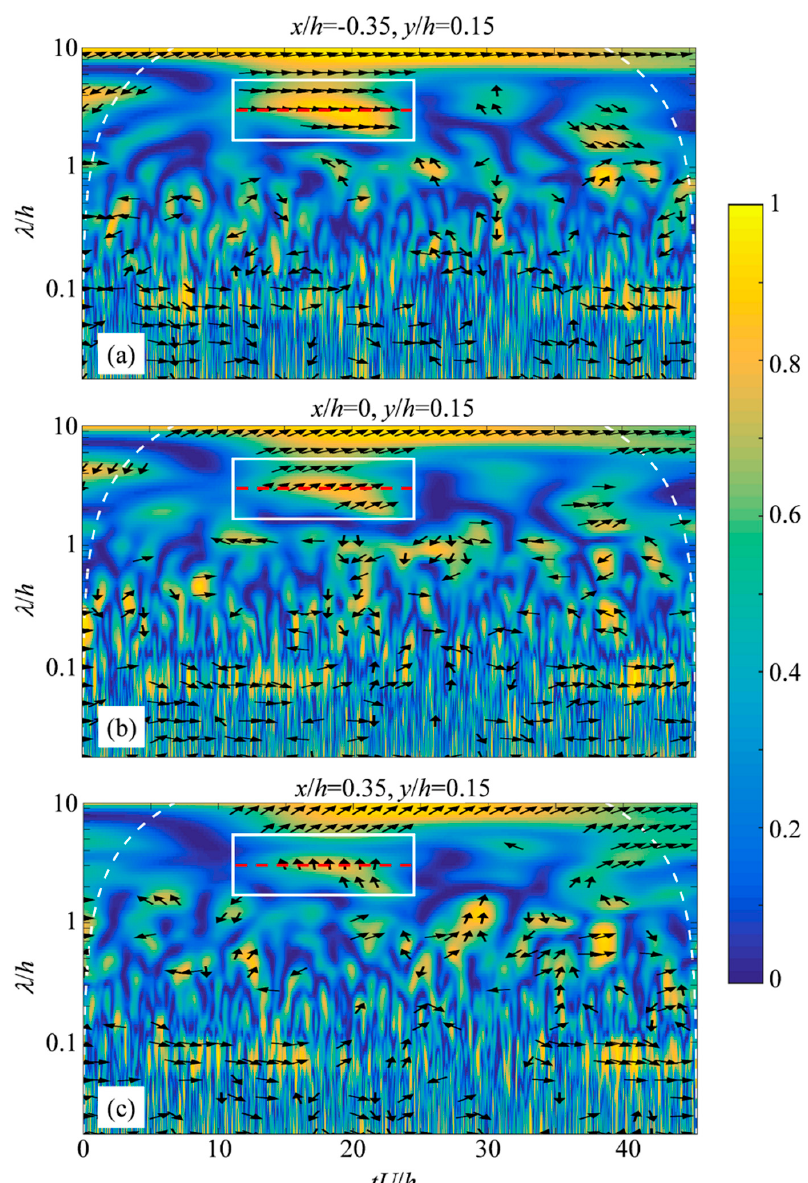
Figure 5. Wavelet coherent coefficients between the streamwise velocity series at different measurement points. The fixed point is ( x / h = 0, y / h = 0.5), the moving points are ( x / h = − 0.35, y / h = 0.15), ( x / h = 0, y / h = 0.15), and ( x / h = 0.35, y / h = 0.15). The highly coherent area reduces and the phase angle increases when the lower point moving from the upstream to downstream of the fixed upper point.